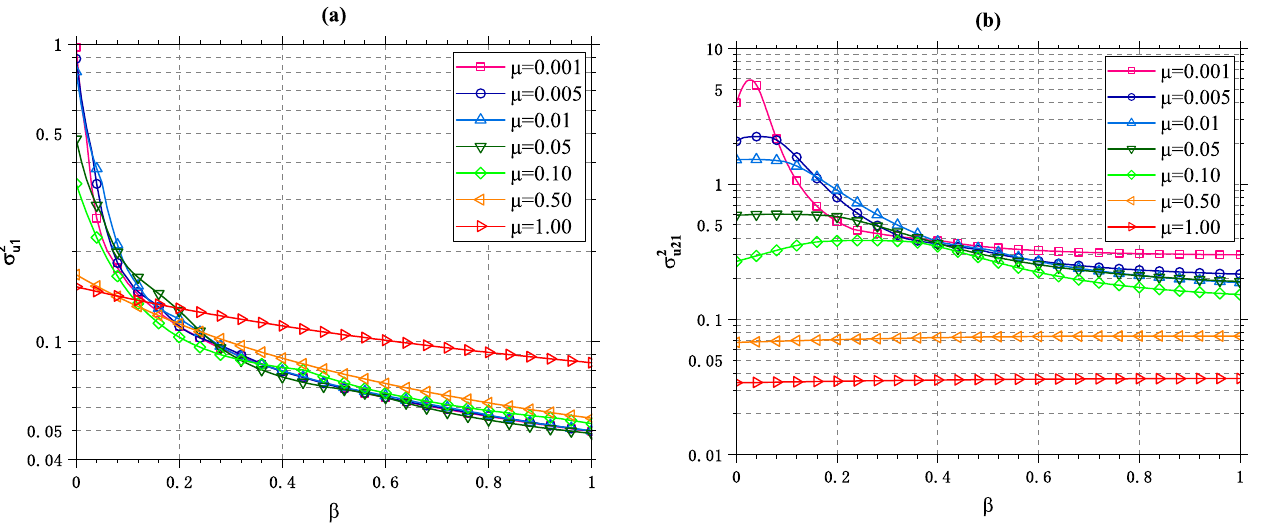
Figure 5. Variance 𝜎 (cid:3048)(cid:2869)(cid:2870) ( a ) and 𝜎 (cid:3048)(cid:2870)(cid:2869)(cid:2870) ( b ) of the displacement and relative displacement of the main Figure 5. Variance σ 2 ( a ) and σ 2 ( b ) of the displacement and relative displacement of the main u 1 u 21 structure at different values of 𝜇 for different values of parameter 𝛽 . structure at different values of µ for different values of parameter β